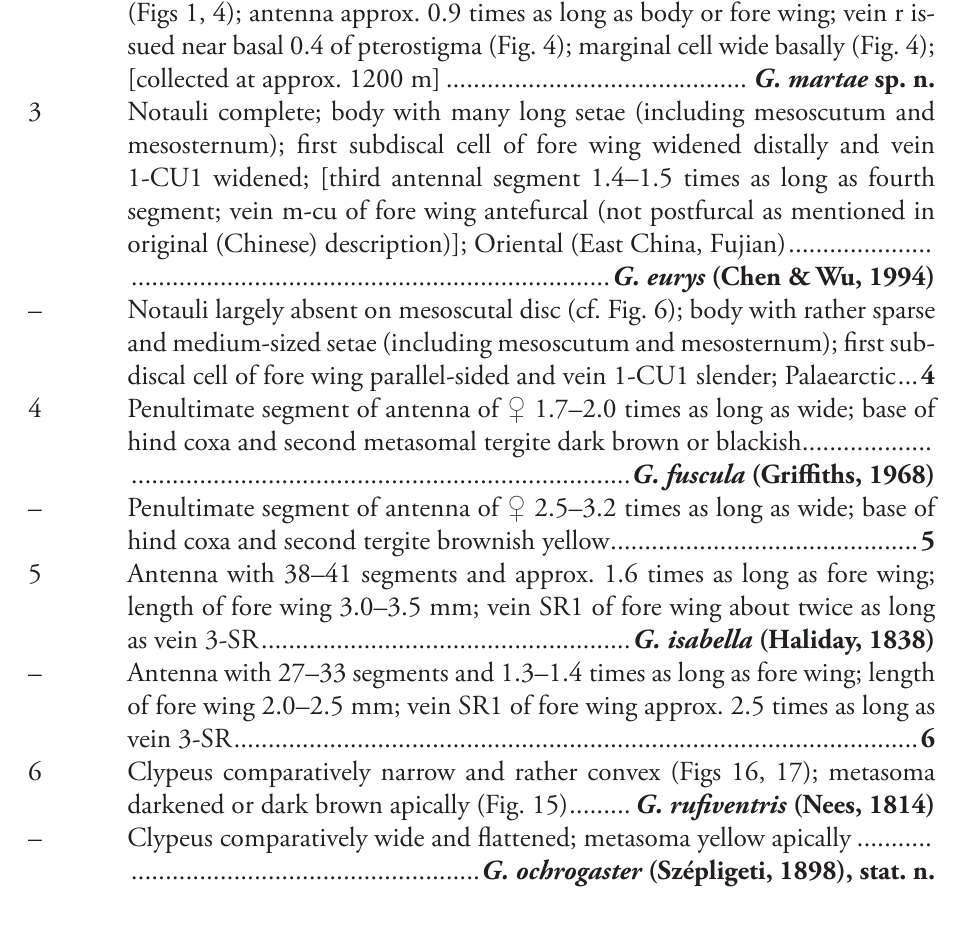
Antenna of ♀ 0.9–1.3 times as long as body and 0.9–1.1 times as long as fore wing; if 1.1 times fore wing then vein 1-R1 of fore wing 0.8 times as long as Antenna of ♀ 1.4–1.9 times as long as body and 1.1–1.6 times as long as fore wing; if 1.1 times fore wing then vein 1-R1 of fore wing about as long as Vein CU1b of fore wing present, resulting in a closed first subdiscal cell; antenna approx. 1.3 times as long as body and 1.0–1.1 times as long as fore wing; vein r issued near basal 0.3 of pterostigma; marginal cell compara-